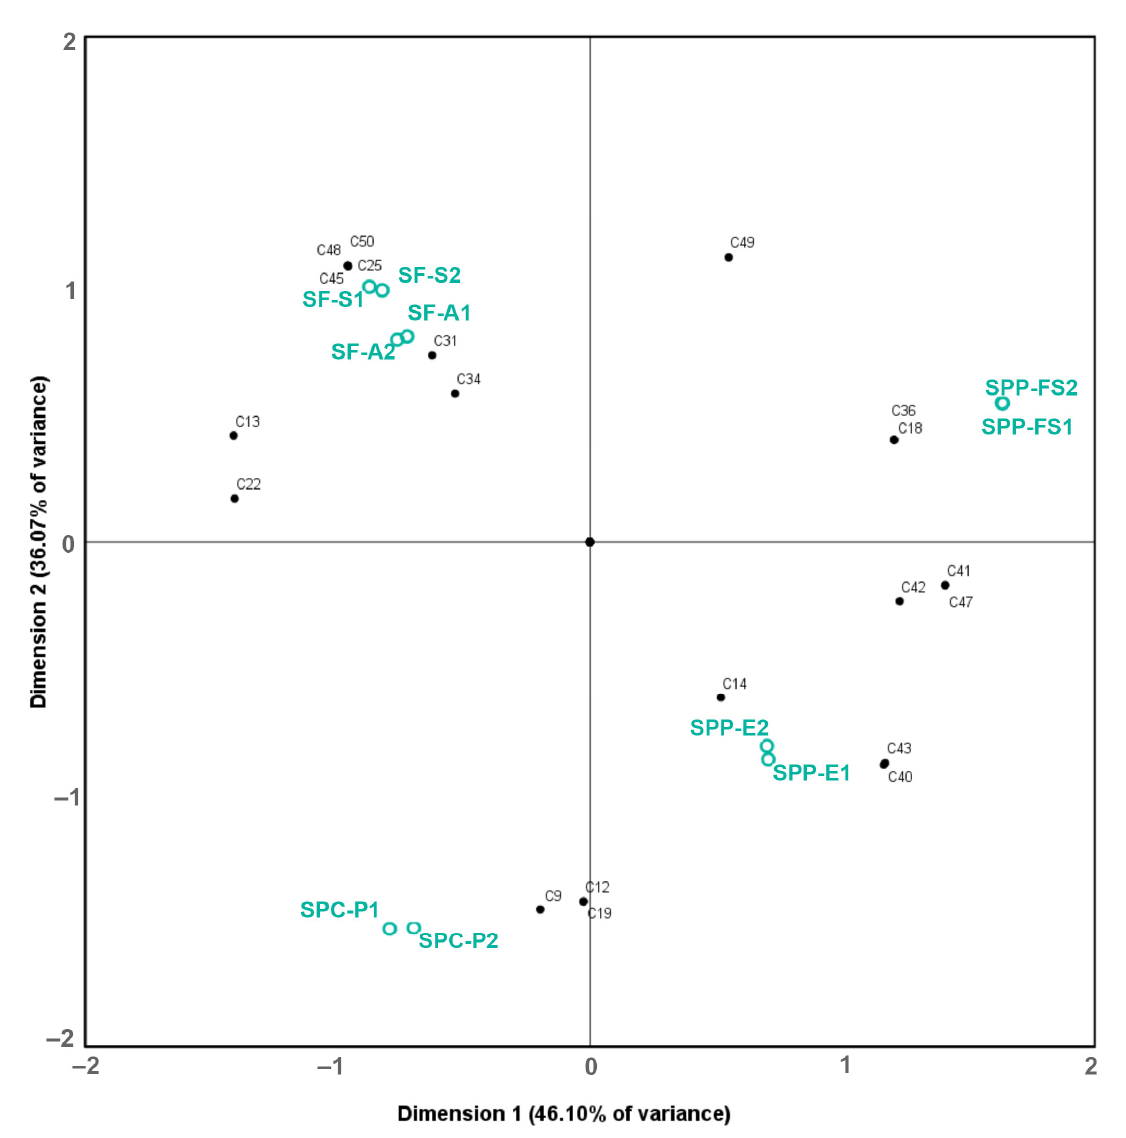
Figure 2. PCA biplots (after Varimax rotation) of polar secondary metabolites in hydroalcoholic extracts of Salvia populations. The numbering of compounds is in accordance with that in Table 2.